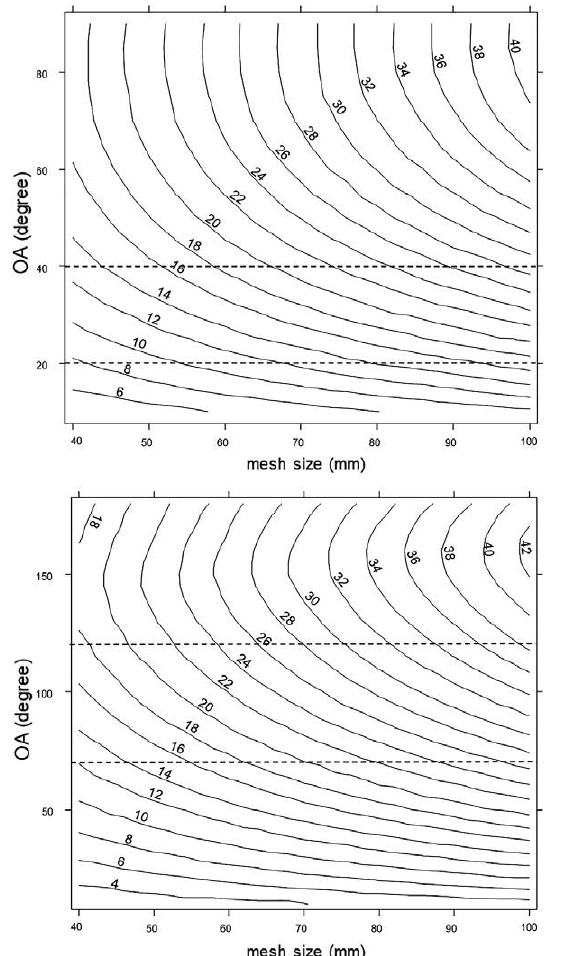
Fig. 9. – Design guides for diamond meshes showing L50 iso-lines (cm) for OA values between 10° and 90° (top) and for hexagonally distorted square meshes showing L50 isolines (cm) for opening an- gles between 10° and 180° (bottom) of hake for mesh sizes between 40 and 100